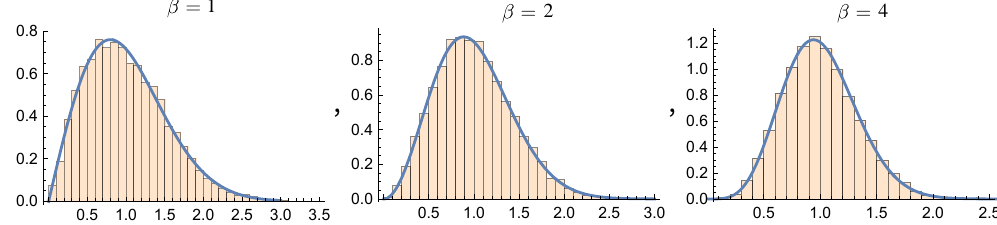
Figure 1: The distribution of three ensembles mentioned in the text.